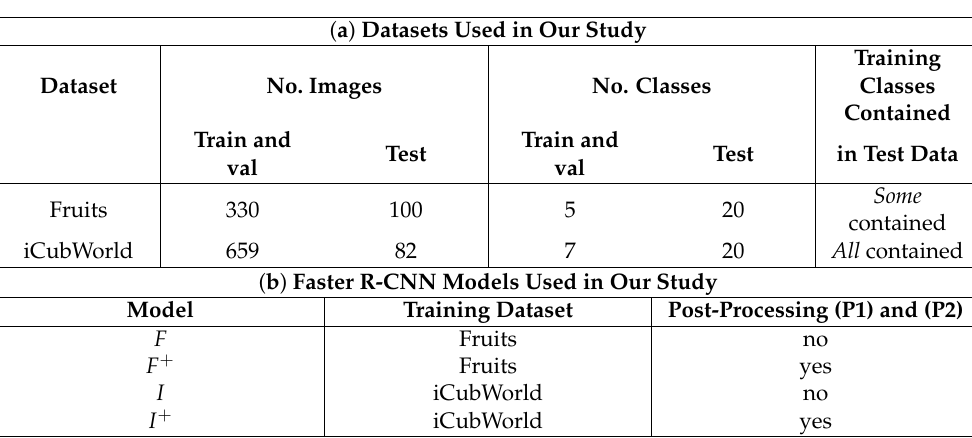
Table 1. Summary of (a) datasets and (b) models used in our study. The manually annotated images are split into 90% training and 10% validation data. In addition, a set of unlabeled images is used for testing. The Faster R-CNN models trained on the fruit and iCubWorld datasets are denoted by F and I , respectively. The models F + and I + denote the corresponding models after application of the post-processing steps (P1) and